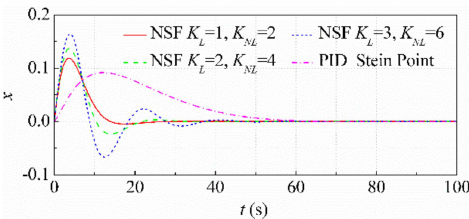
Figure 27. Comparison between the regulation qualities of the nonlinear state feedback (NSF) control strategy and the proportional integral derivative (PID) strategy. Reproduced with permission from [45], Elsevier, 2017.